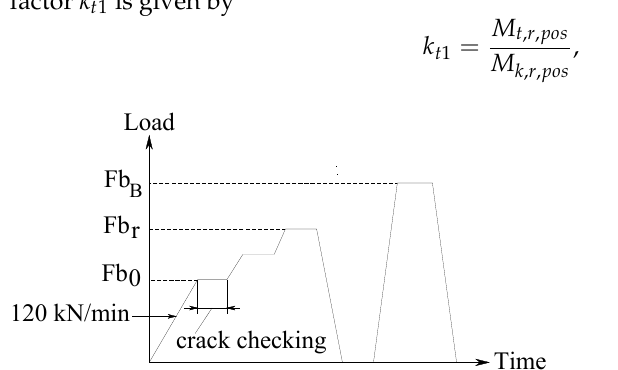
Figure 9. Static test procedure for design approval test for the positive bending moment.